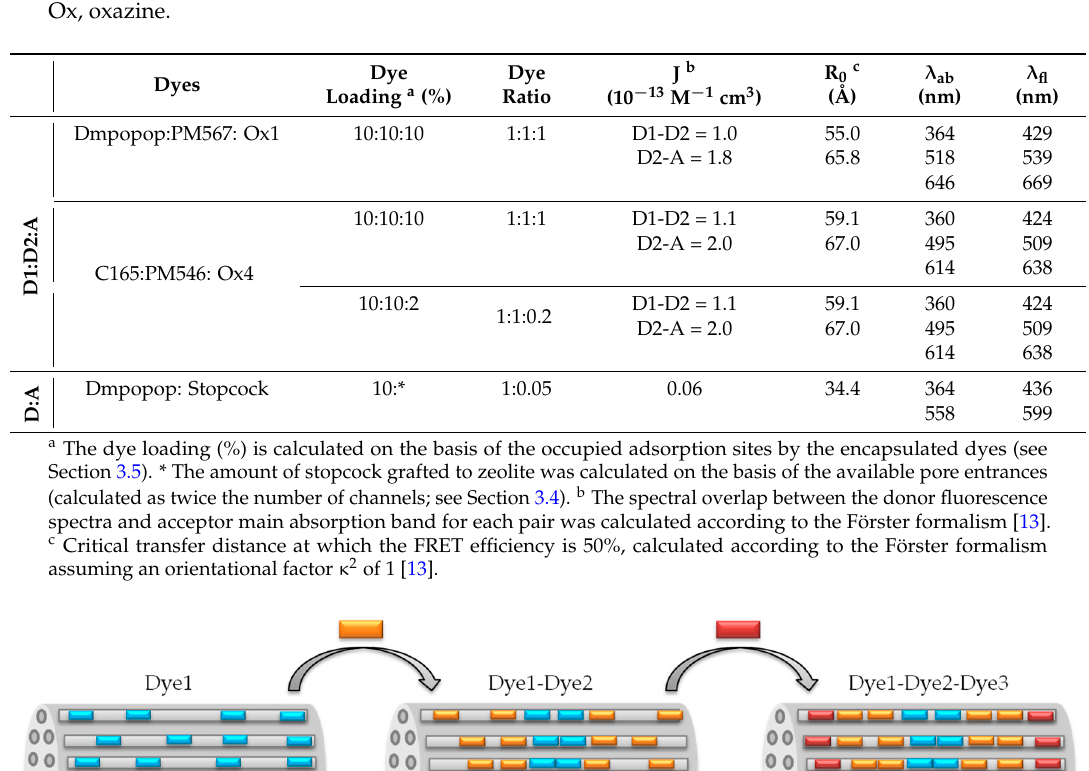
Table 1. Meaningful data about dye loadings, spectral band positions and the ongoing FRET between the dyes occluded or anchored into the disc-shaped LTL zeolite: dye loadings, donor-acceptor ratio, spectral overlap (J), absorption ( λ ab ) and fluorescence ( λ fl ) peak wavelengths. C165, carbostyril; Ox, oxazine.